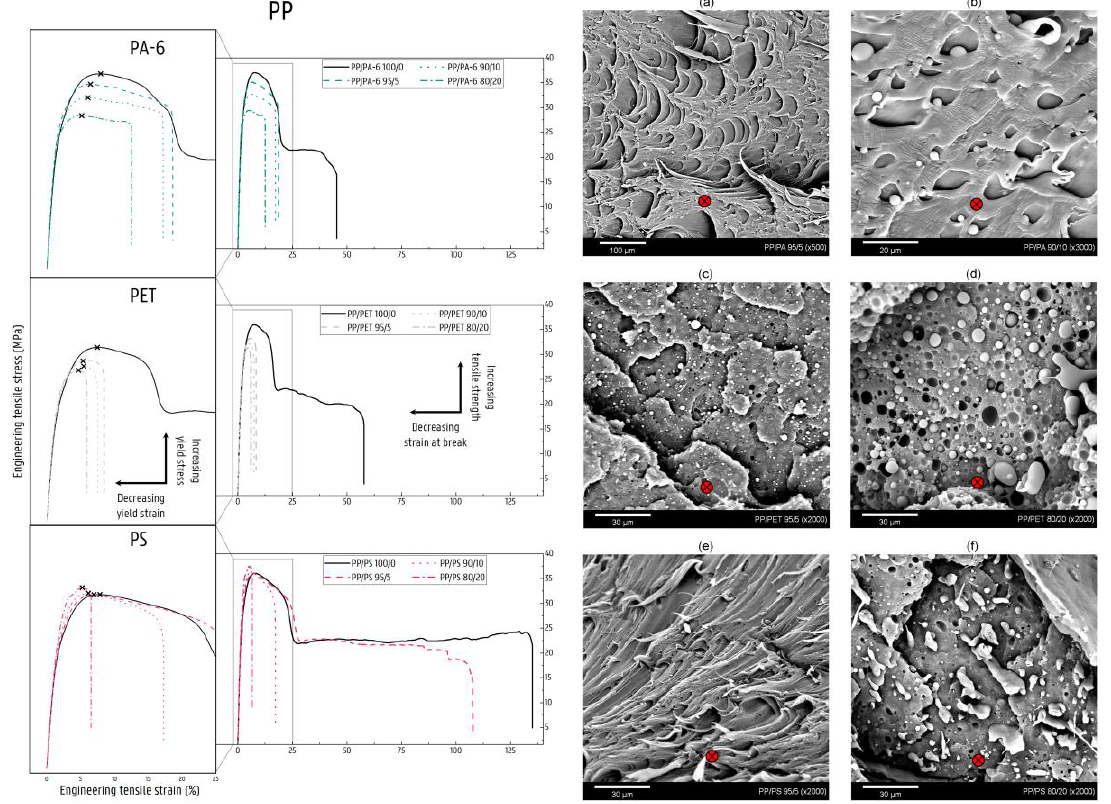
Figure 11. Stress–strain curves of the NPO-contaminated PP matrices (0, 5, 10, and 20 wt% PA-6, PET, or PS). The scanning electron microscopy (SEM) images show the area of rupture of the tensile-tested (deformed) binary blend specimens: ( a ) PP/PA 95/5, ( b ) PP/PA 90/10, ( c ) PP/PET 95/5, ( d ) PP/PET 80/20, ( e ) PP/PS 95/5, and ( f ) PP/PS 80/20. The red arrow indicates the polymer